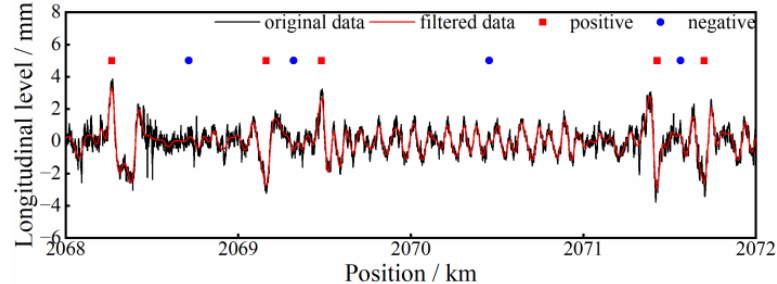
Figure 9. Longitudinal-level waveform and corresponding